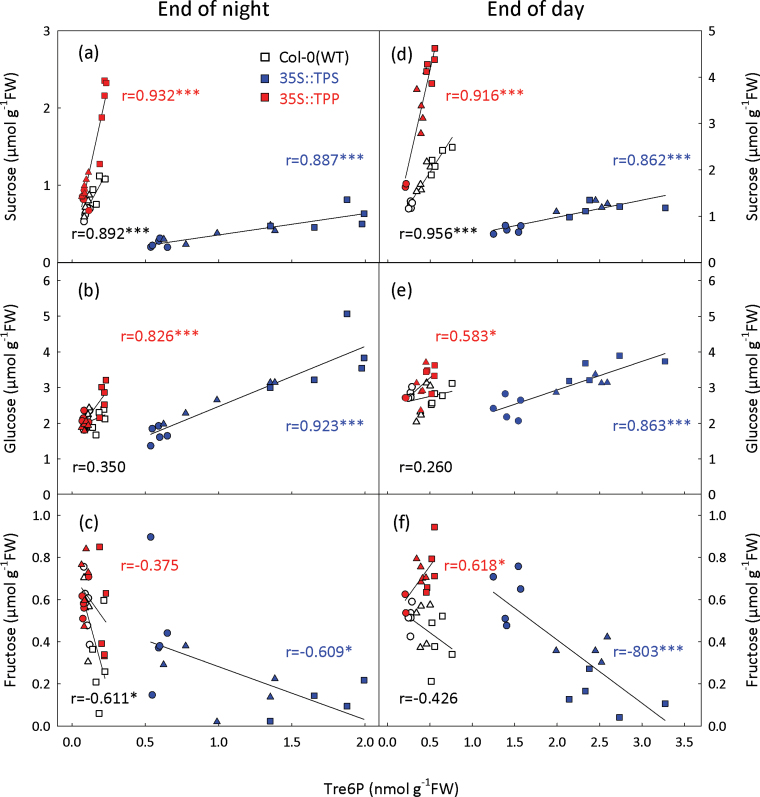
Effect of constitutive TPS and TPP expression on the relationship of Tre6P to sugars in A. thaliana. WT (Col-0), 35S::TPS, and 35S::TPP plants were grown under 8h (circles), 12h (triangles), or 16h (squares) day lengths. Rosettes were harvested from 25-d-old plants at (a–c) the end of the night and (d–f) end of the day. The Tre6P content of the individual samples was plotted against: sucrose (a, d), glucose (b, e), and fructose (c, f). The Pearson correlation coefficient (r) for each metabolite pair is shown. Asterisks indicate significant correlations: *P<0.05, ***P<0.001.